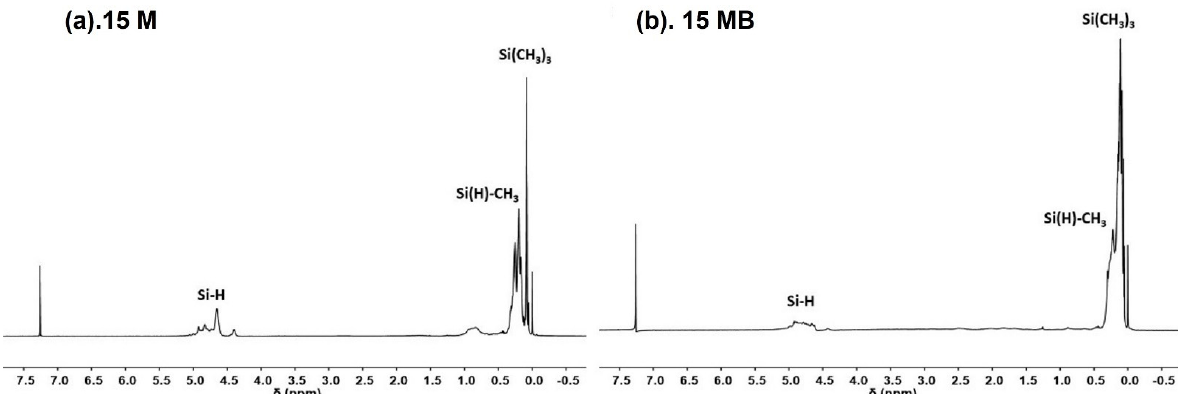
Figure 1. Structural characterization of 1H-NMR: ( a )15 M and ( b )15 MB.